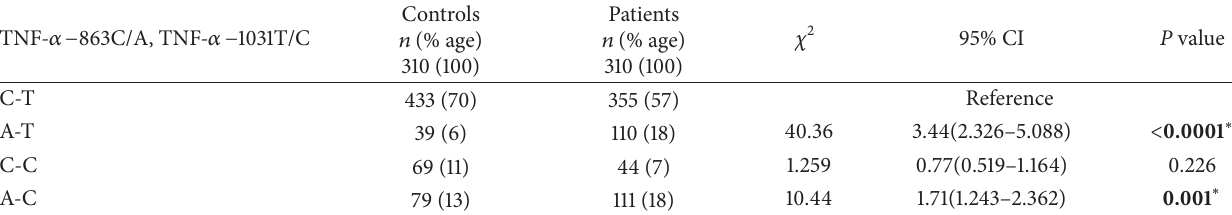
Table 3: Haplotype analysis of TNF- 𝛼− 1031T > C and − 863C > A polymorphisms in the study